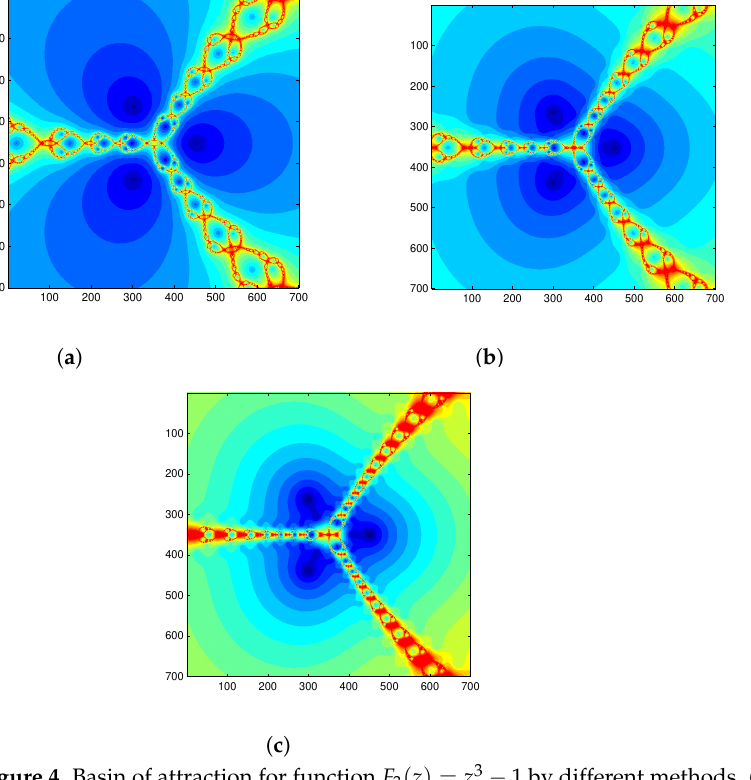
Figure 4. Basin of attraction for function F 3 ( z ) = z 3 − 1 by different methods. ( a ) Modified Newton method h = 1.0, ( b ) Damped Modified Newton method h = 0.75, ( c ) Damped Modified Newton method h =